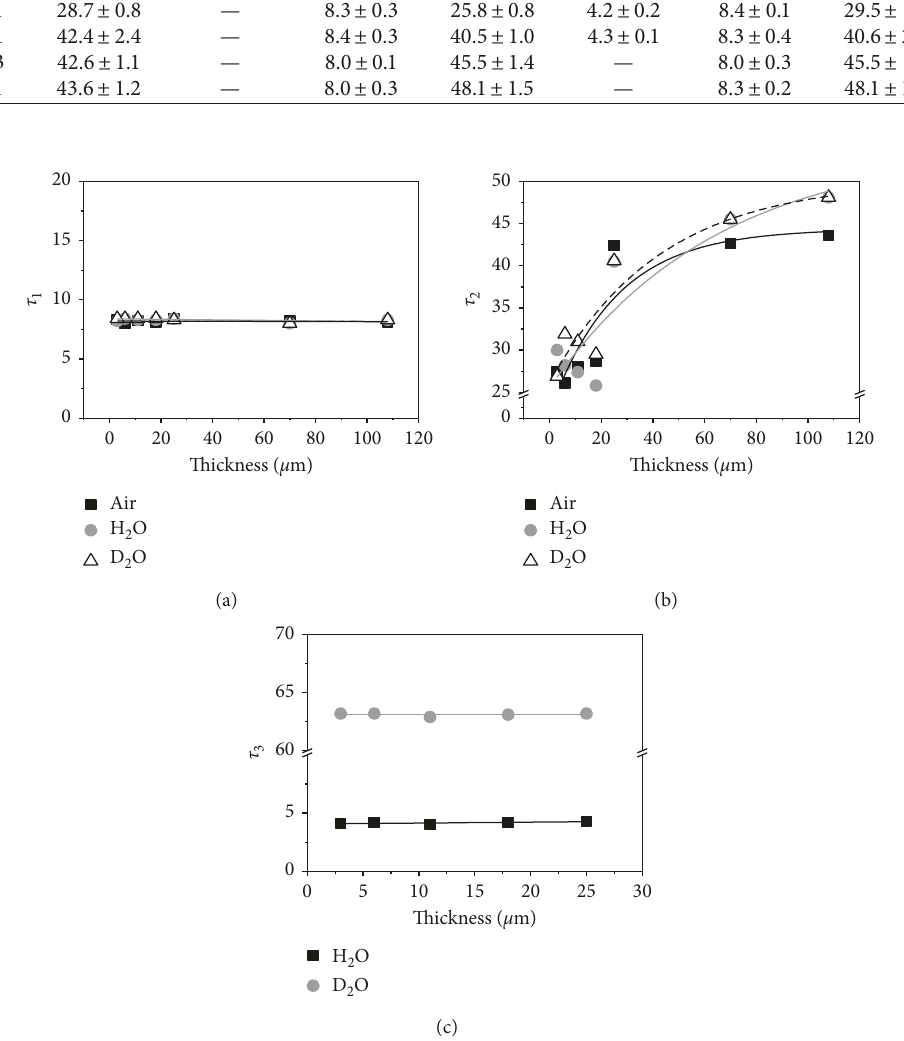
Figure 3: Plots for singlet oxygen lifetime of Component A, B, and C vs. the thickness of PFPFs in the H